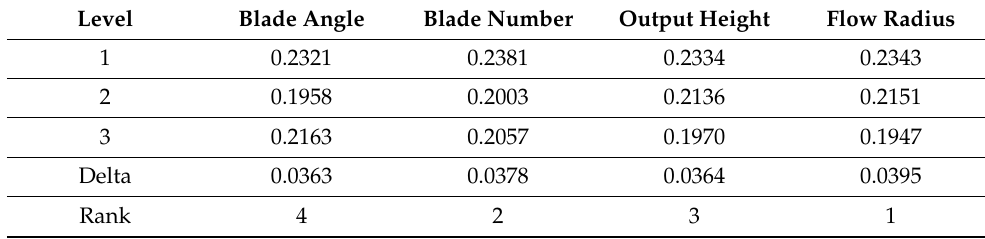
Table 8. Central flow analysis of